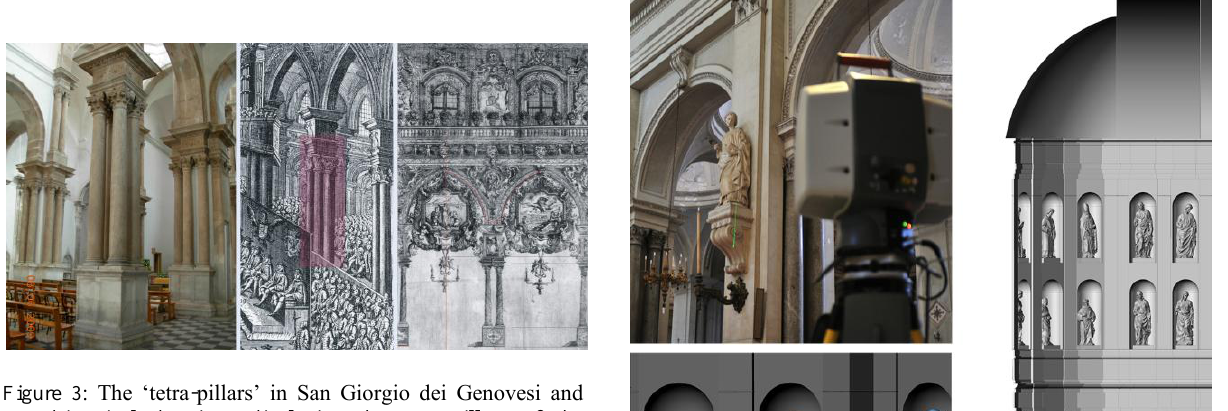
Figure 2: Reconstruction of the nave before the ‘Riforma’.